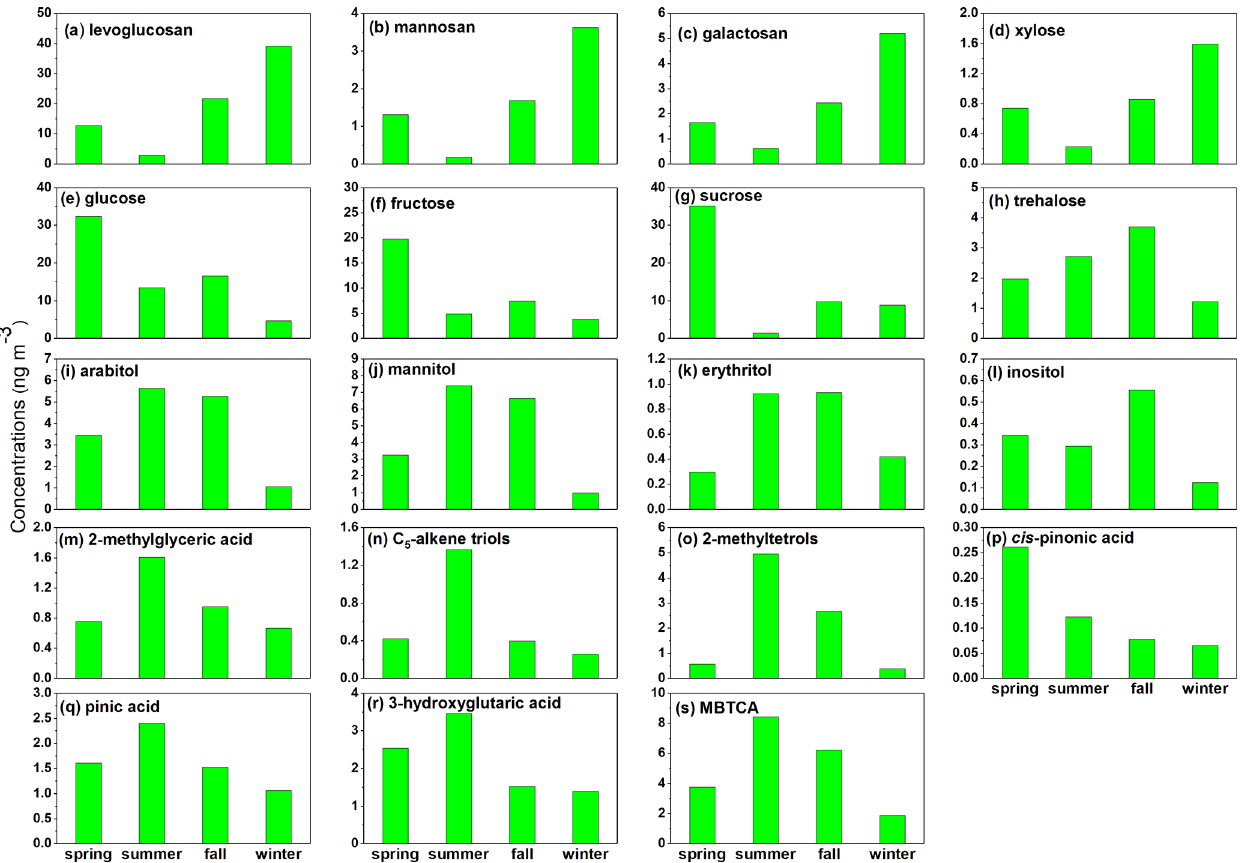
Figure 3. Seasonal variability in the atmospheric levels of sugar compounds and BSOA tracers in TSP samples from Gosan during April 2013–April